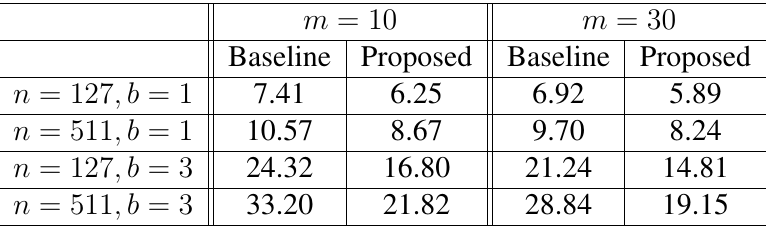
Table 1. Comparison of mean